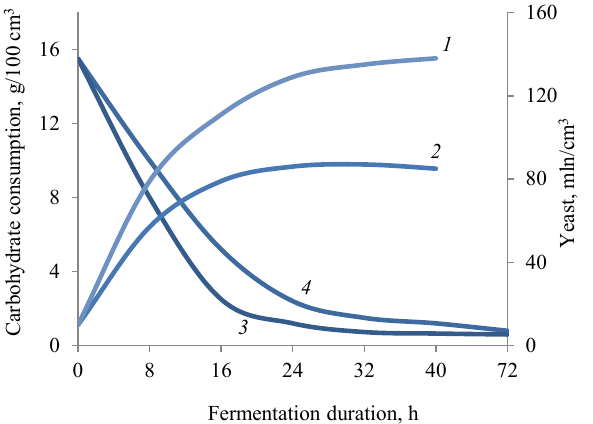
Figure 3 Composition of volatile by-products during fermentation of rye wort made with glucoamylase enzyme preparations derived from Aspergillus awamori